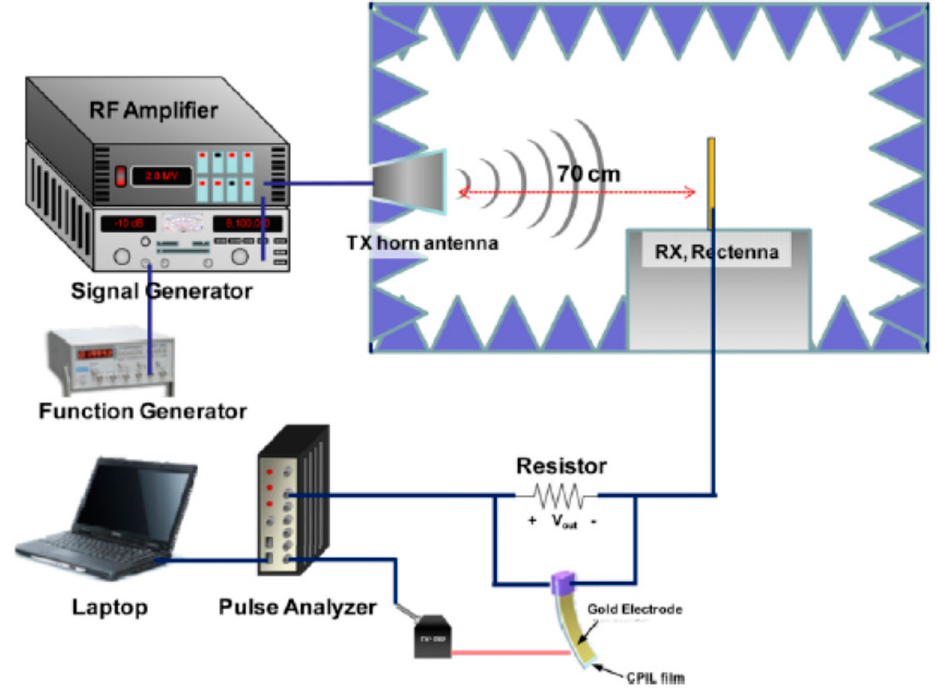
Figure 10. Schematic of microwave power transmission test setup [101].